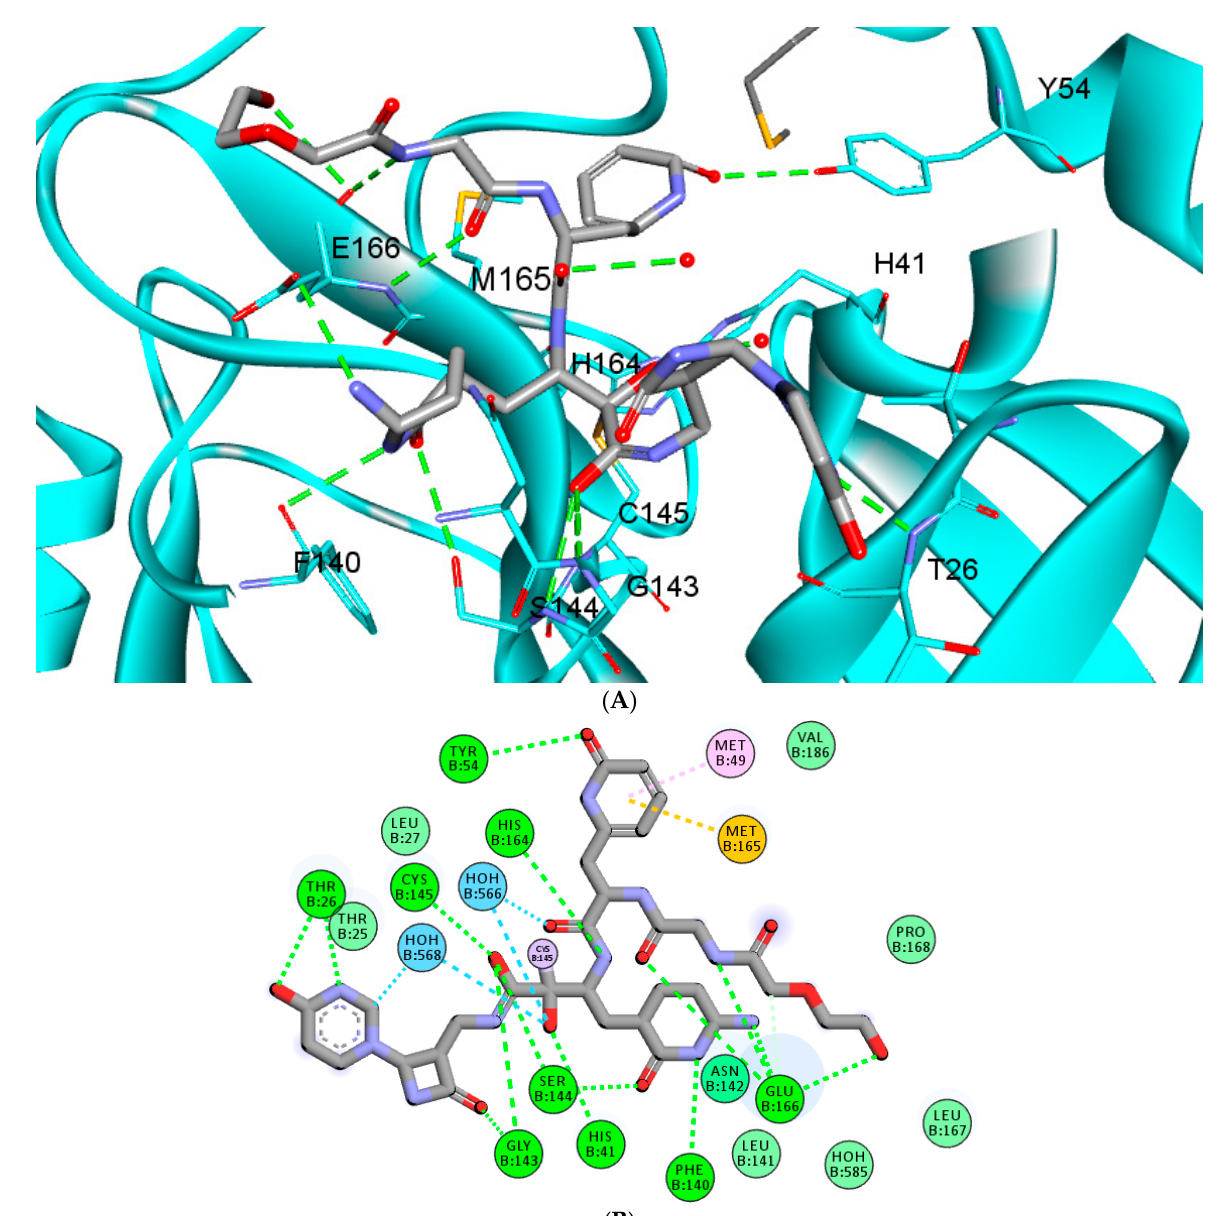
Figure 3. The re-docked pose (cyan) superimposed on the co-crystalized (pink).